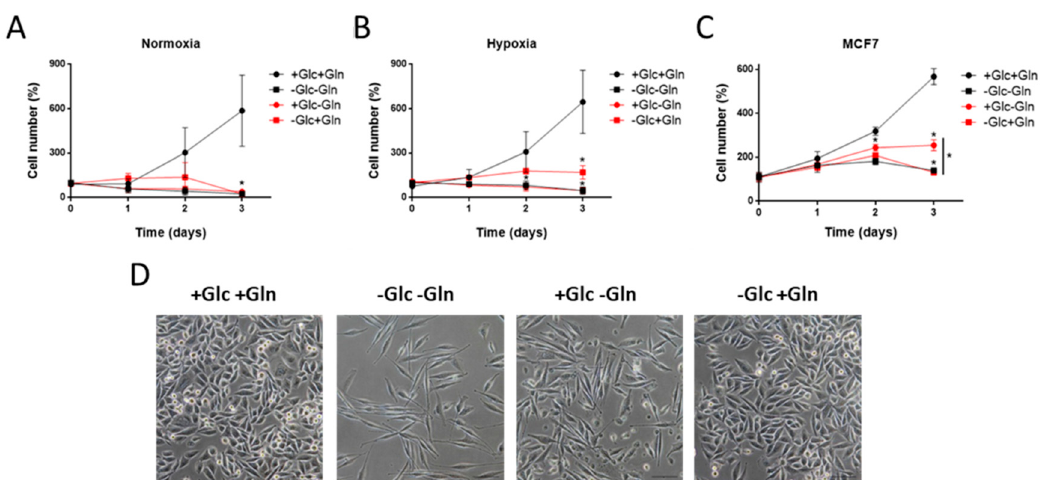
Figure 1. Effect of glucose and/or glutamine starvation on the proliferation of breast cancer cells. ( A ) Cell growth in normoxia and ( B ) hypoxia (1% O 2 ) for MDA-MB-231 cells, and ( C ) in normoxia for MCF7 cells under different combinations of 5 mM glucose and 0.5 mM glutamine. ( D ) Representative photographs of MDA-MB-231 cells’ morphology under different glucose and/or glutamine starvation conditions for 24 h. Bar scale = 200 μ m. Data are expressed as means ± standard deviation (SD) of three independent experiments. * p < 0.05 versus glucose and glutamine conditions.